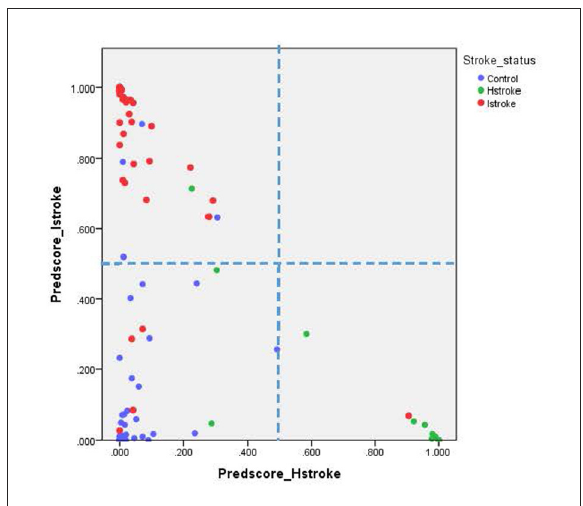
FIGURE6 Scatter plot for both ischemic and haemorrhagic strokes.